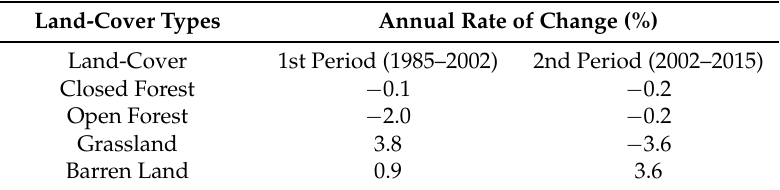
Figure 2. Land-cover maps of the Lembus Forest in ( a ) 1985; ( b ) 2002; and ( c ) 2015. Table 4. Annual rate of change per land-cover class during the two